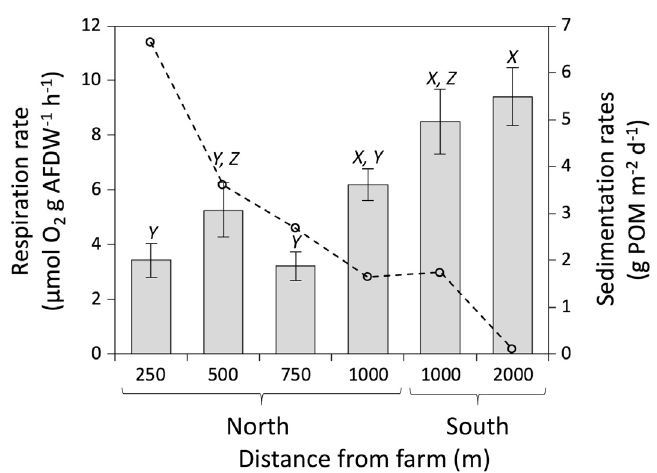
Fig. 2. Respiration rates (mean ± SE) of Lophelia pertusa coral fragments after 1 yr of transplantation from Kjerring revet (a nearby cold-water coral reef) to a gradient away from a salmon fish farm. n = 6 for all sites. Dashed line shows the modelled av- erage daily sedimentation rates during the 1 yr transplantation experiment. Letters above the bars show statistically distinct groups as identified by Tukey’s HSD test (p < 0.05). AFDW: ash-free dry weight; POM: particulate organic